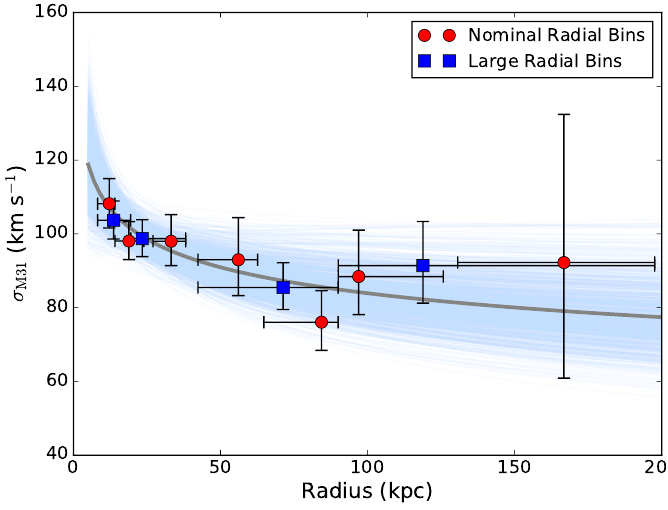
Figure 4. The stellar velocity dispersion of M31’s halo as a function of projected distance from M31’s center (Figure 10 of Gilbert et al. [9]). Points, placed at the median radius of all stars in the bin (with error bars denoting the full range of radii), show the 50th percentile of the marginalized one-dimensional posterior probability distribution for the velocity dispersion, with the error bar denoting the 16th to 84th percentile. The light blue curves show a subset of power-law fits to random draws from the posteriors; the dark gray curve shows a power-law defined by the 50th percentile values for the normalization and slope distributions. The velocity dispersion of stars in M31’s halo remains relatively flat, with only a weak gradient, out to large